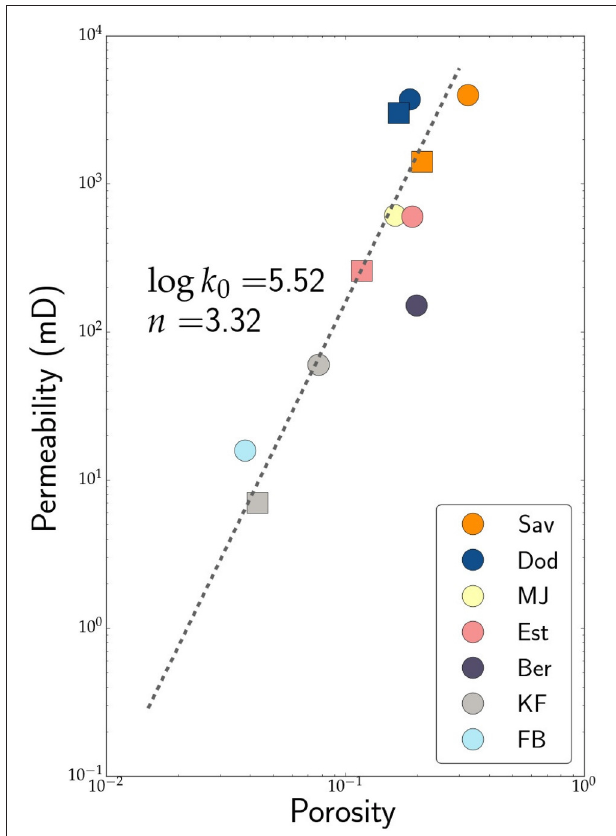
FIGURE 7 | Plot of porosity and permeability from our samples and Fontainebleau (FB) and Berea (B) sandstones from Thomson et al. (2018). Filled circles represent data from total porosity while filled squares represent data from macroporosity alone. The broken line is a fit to the data of the form k = k 0 φ n . The fit parameters are annotated in the